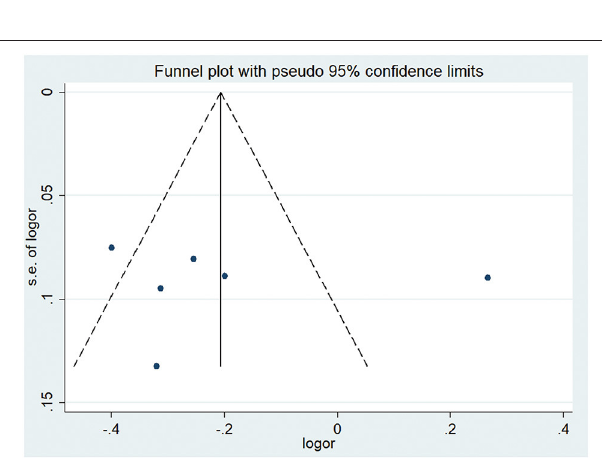
FIGURE 7 | Funnel plot of sKlotho levels and